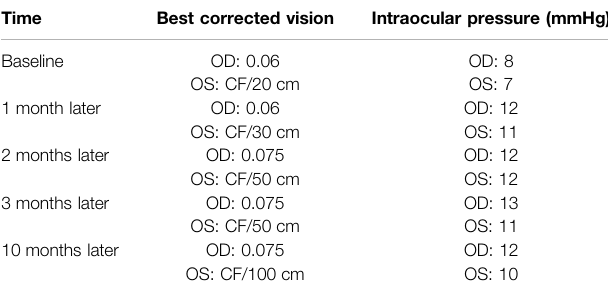
TABLE 1 | Best corrected vision and intraocular pressure of each stage. Time Best corrected vision Intraocular pressure (mmHg)